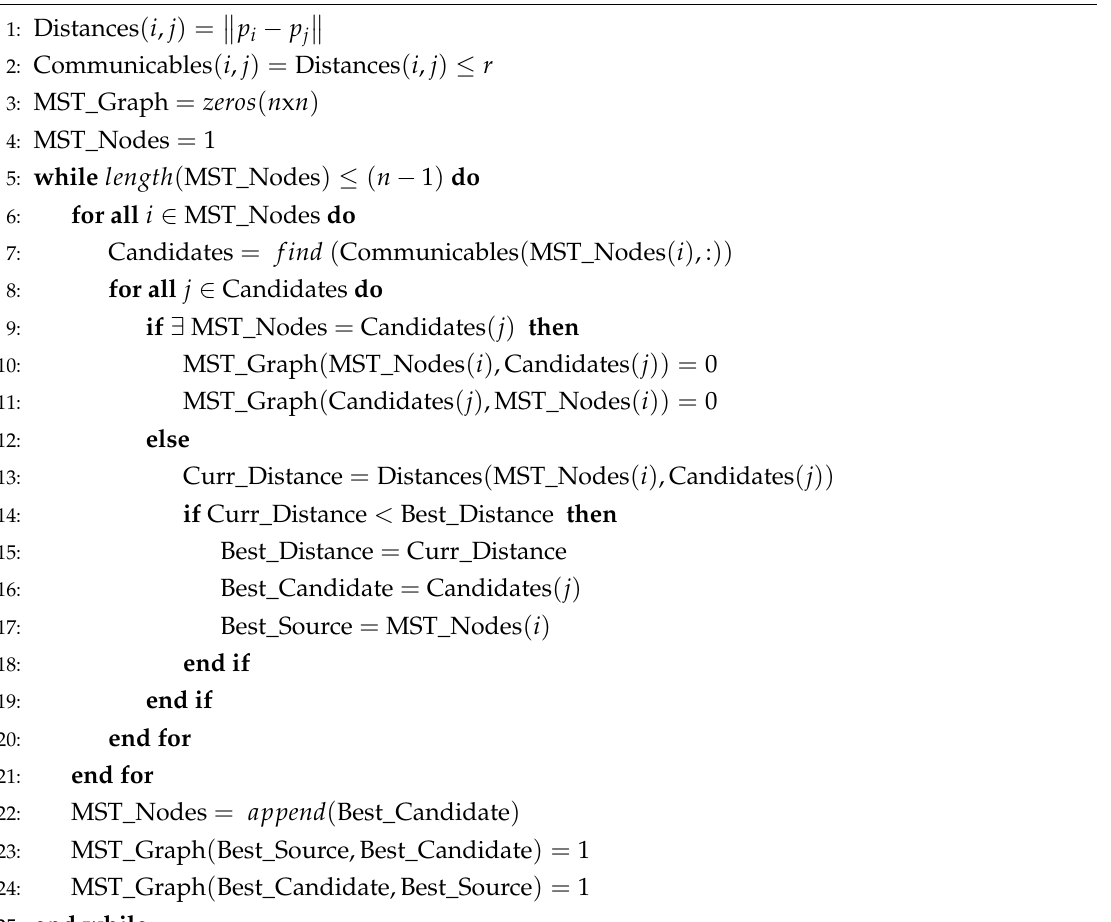
Algorithm 1 MST calculation.